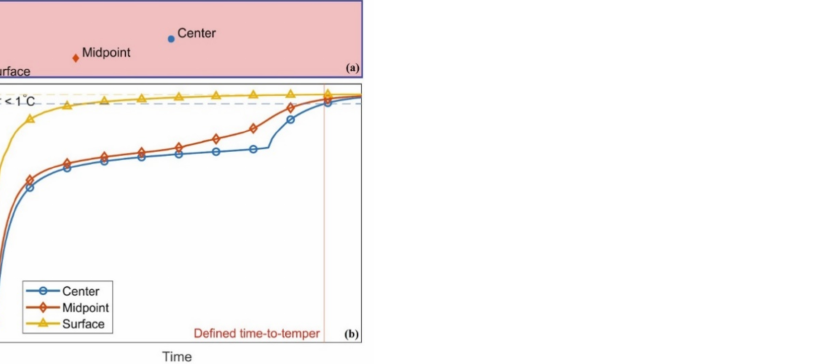
Figure 3. ( a ) Surface, midpoint, and center of the studied sample. ( b ) Tempering time definition based on the temperature distribution. Adapted from Shan and Heldman [136], with permission from the corresponding author,